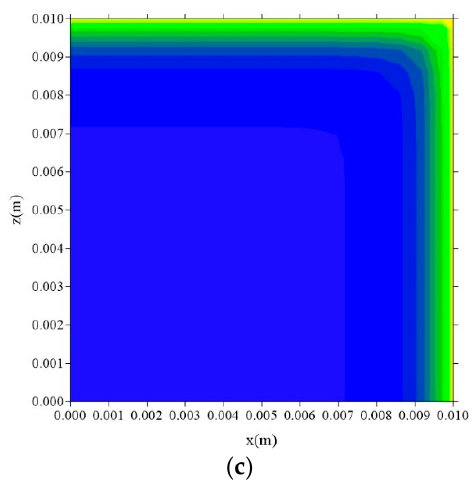
Figure 29. Distribution of the entrapped solute concentration (S in kg/kg) in plan y = R y /2 for different distances l y (t = 211 h, Cases 9, 11, and 12). In which ( a ) l y = 0.001 m; l x = 0.1 m and l z = 0.1 m ; ( b ) l y = 0.01 m; l x = 0.1 m and l z = 0.1 m ; ( c ) l y = 0.1 m; l x = 0.1 m and l z = 0.1 m .